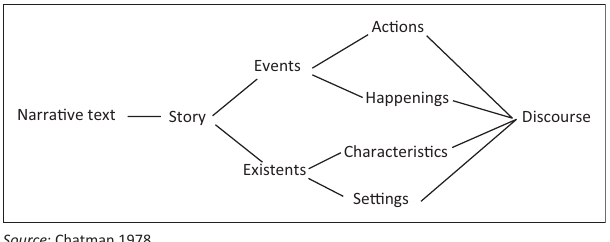
FIGURE 1: The necessary components of a